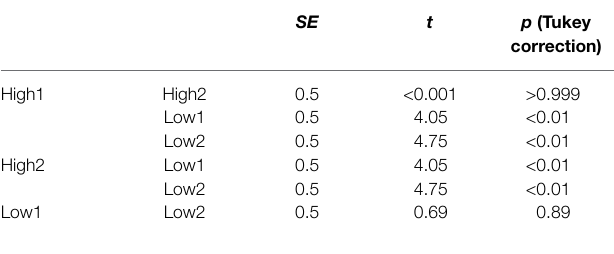
TABLE 1 | Post-hoc comparisons of arousal values (pilot